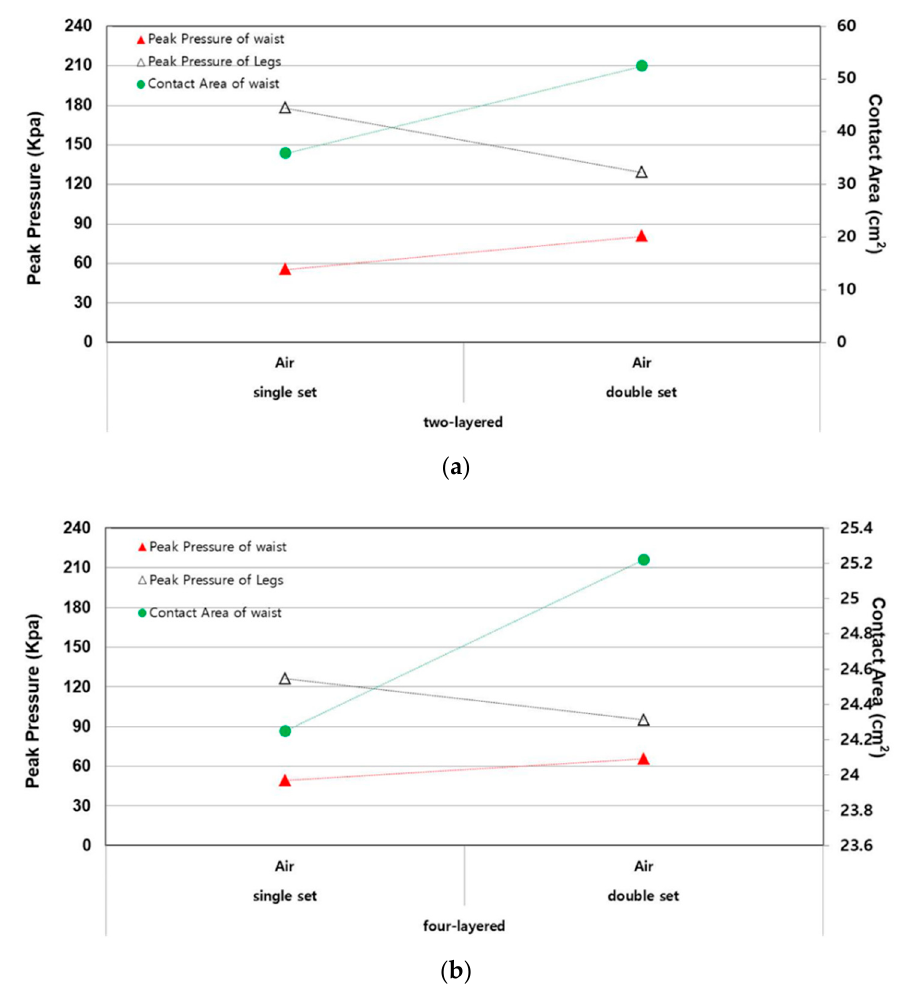
Figure 12. ( a ) Peak and ( b ) mean pressure relationship between waist and leg.